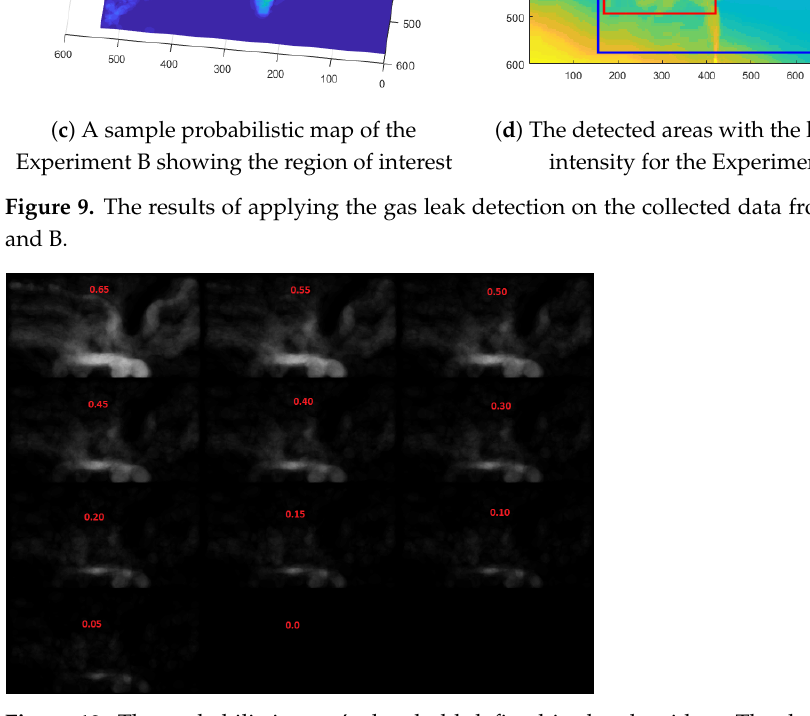
Figure 10. The probabilistic map’s threshold defined in the algorithm. The threshold should be determined based on the collected data and the contained